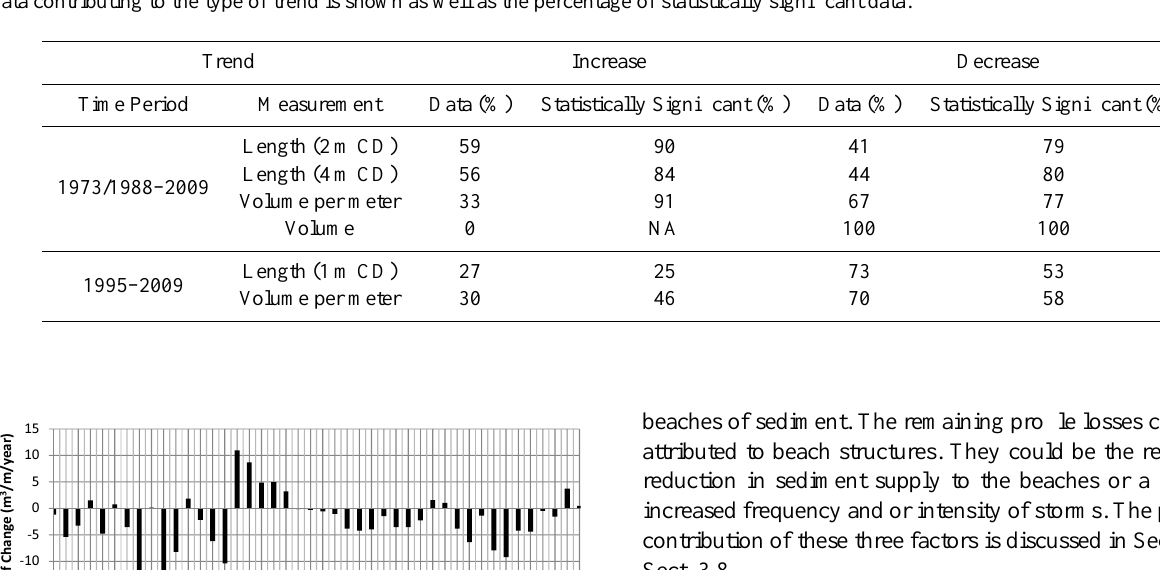
Table 2. Type of trend experienced by the beach length at the 2m and 4m CD contour, volume per meter and volume during the period of 1973/1988 to 2009 and the beach length at the 1m CD contour and volume per meter during the period of 1995 to 2009. The percentage of data contributing to the type of trend is shown as well as the percentage of statistically significant data.